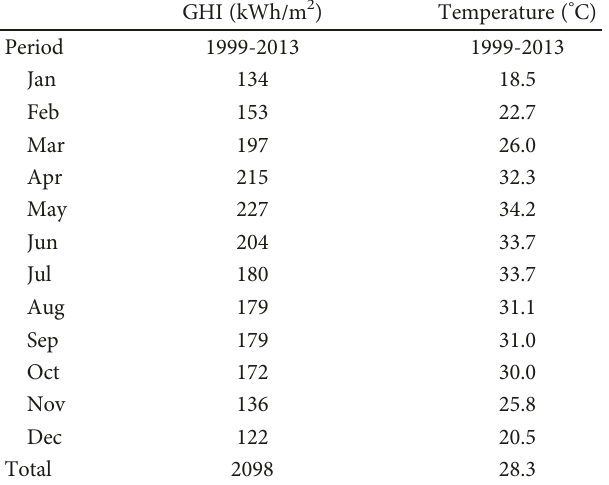
Table 7: Monthly values of GHI and temperature from